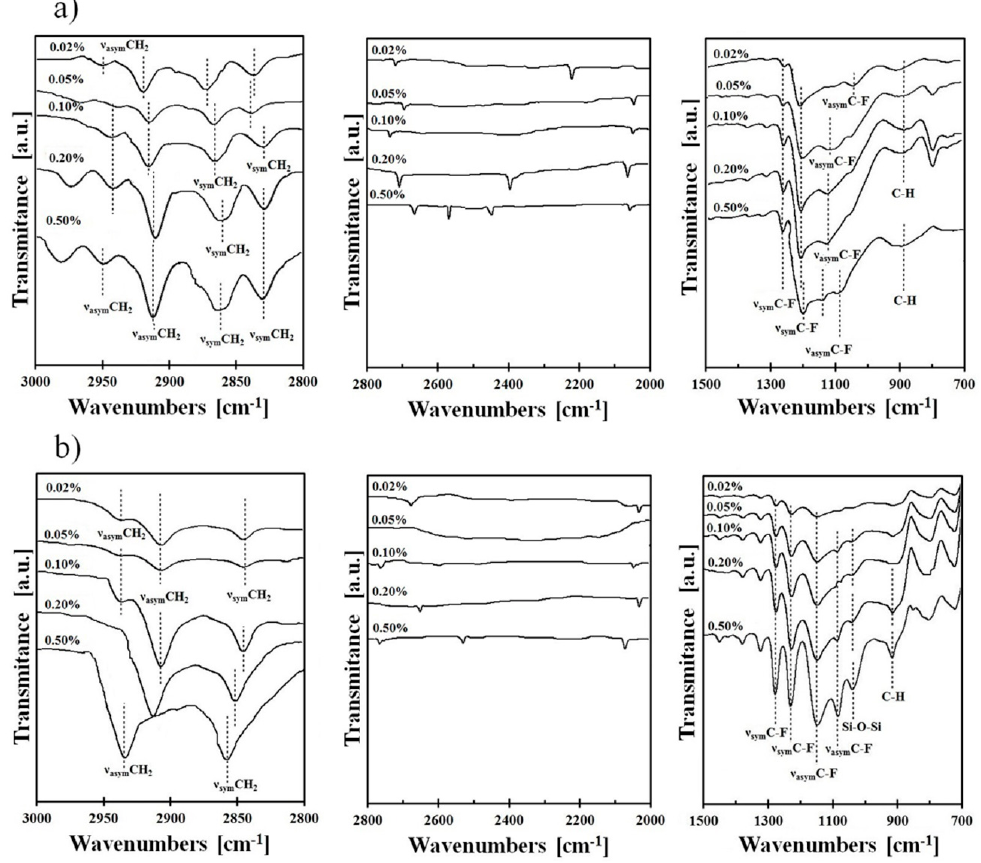
Figure 4. FTIR of typical spectra for ( a ) Si-DLC / FPTS and ( b ) Si-DLC / FDTS in the ranges of 1500–700 cm − 1 , 2800–2000 cm − 1 and 3000–2800 cm − 1 .